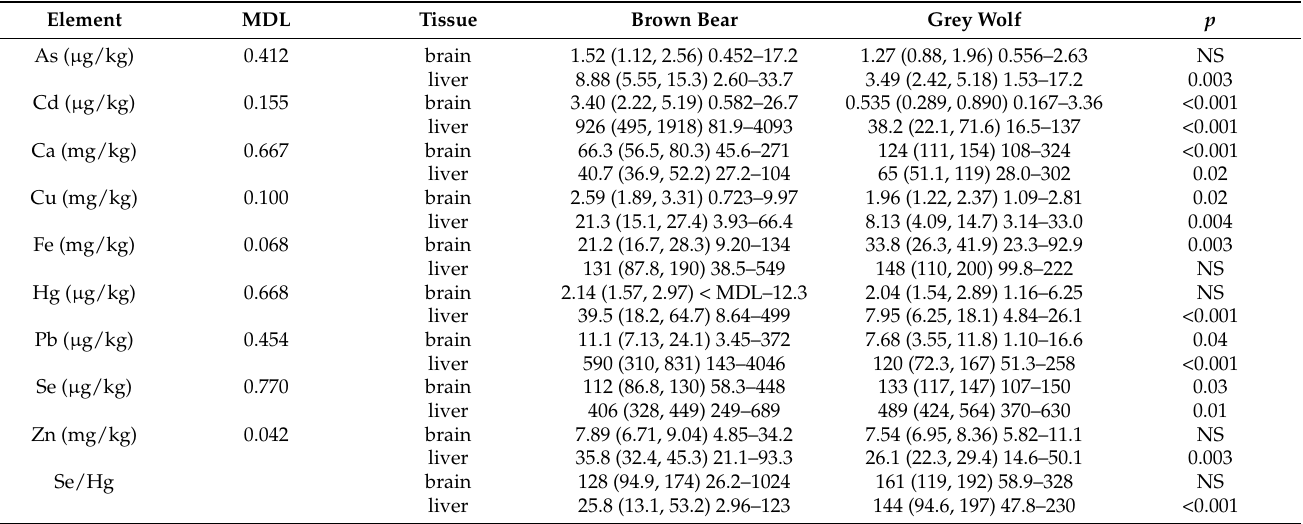
Table 2. Descriptive statistics (median (IQR: Q1, Q3) min-max) and interspecies differences in element levels expressed on a wet-mass basis of brain ( n = 114) and liver tissue ( n = 49) in brown bears and grey wolves ( n = 8) from Croatia 1